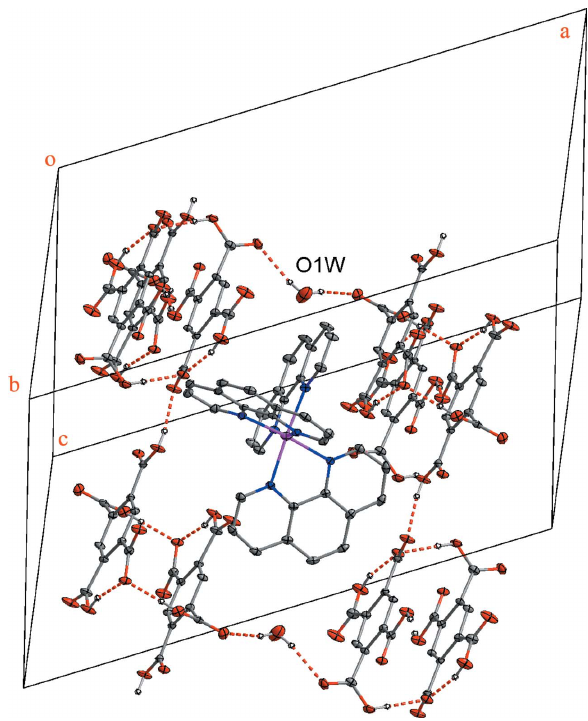
Figure 3 The packing of the title compound. All C-bound H atoms have been omitted for clarity and hydrogen bonds are shown as dashed lines.